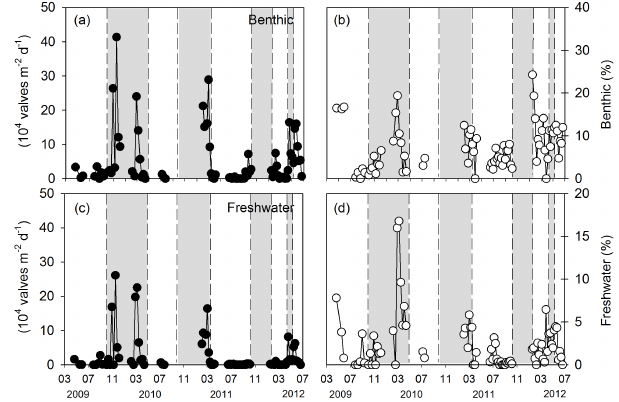
Figure 6. Time series of (a) benthic and (c) freshwater diatom fluxes (and relative contributions respect to total diatoms b, d ) recorded with a PPS 4 / 3 sediment trap at RAIA station. Upwelling and downwelling periods are highlighted with white and grey bars, re- spectively, based on upwelling index and biogeochemical data pre- sented in Zúñiga et al. (2016).